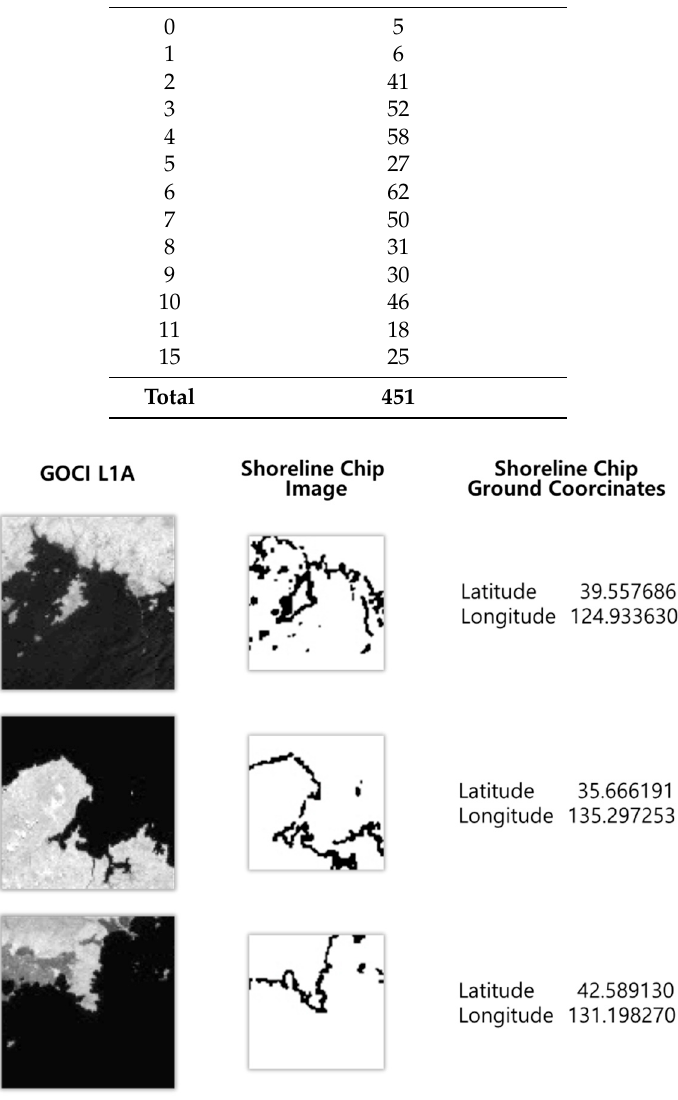
Figure 10. Examples of shoreline chips.